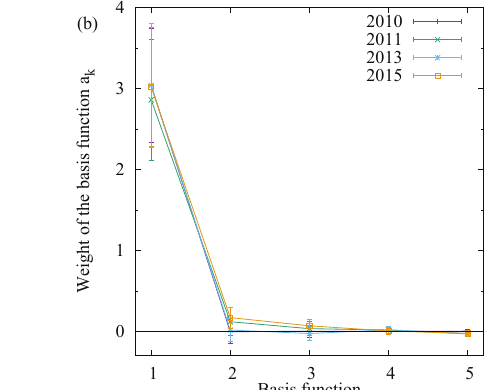
Figure 3. Basis functions for the forest directional reflectance factor. Gaps in data are due to weak signal in the absorption bands of water vapor in the atmosphere.